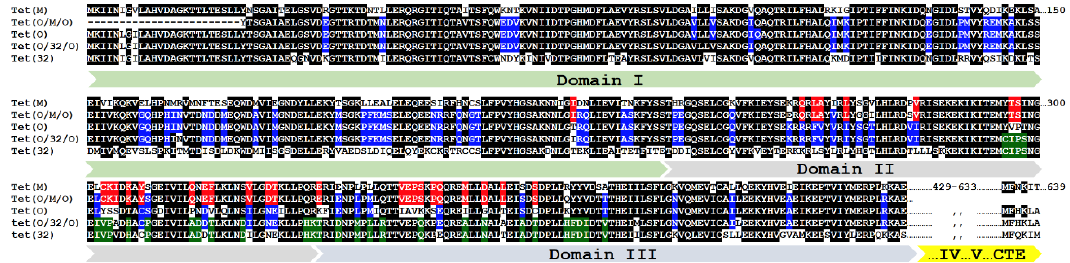
Figure 3. Chimeric structure of Tet(O/M/O) and Tet(O/32/O) mosaic proteins. Amino acid sequence shown are: Tet(M), WP_004632336; Tet(O), EAI7795628; Tet(32), WP_002602099.1; Tet(O/32/O), AINH01000038; Tet(O/M/O), this work (100% identical to WP_002872163, encoded by AY394560.1 ). Identity color code: black, homology ≥ 80% among sequences; blue, homology ≥ 60% among tet (O), tet (O/M/O) and/or Tet(O/32/O); red, tet (M) and tet (O/M/O); green, tet (32) and tet (O/32/O).